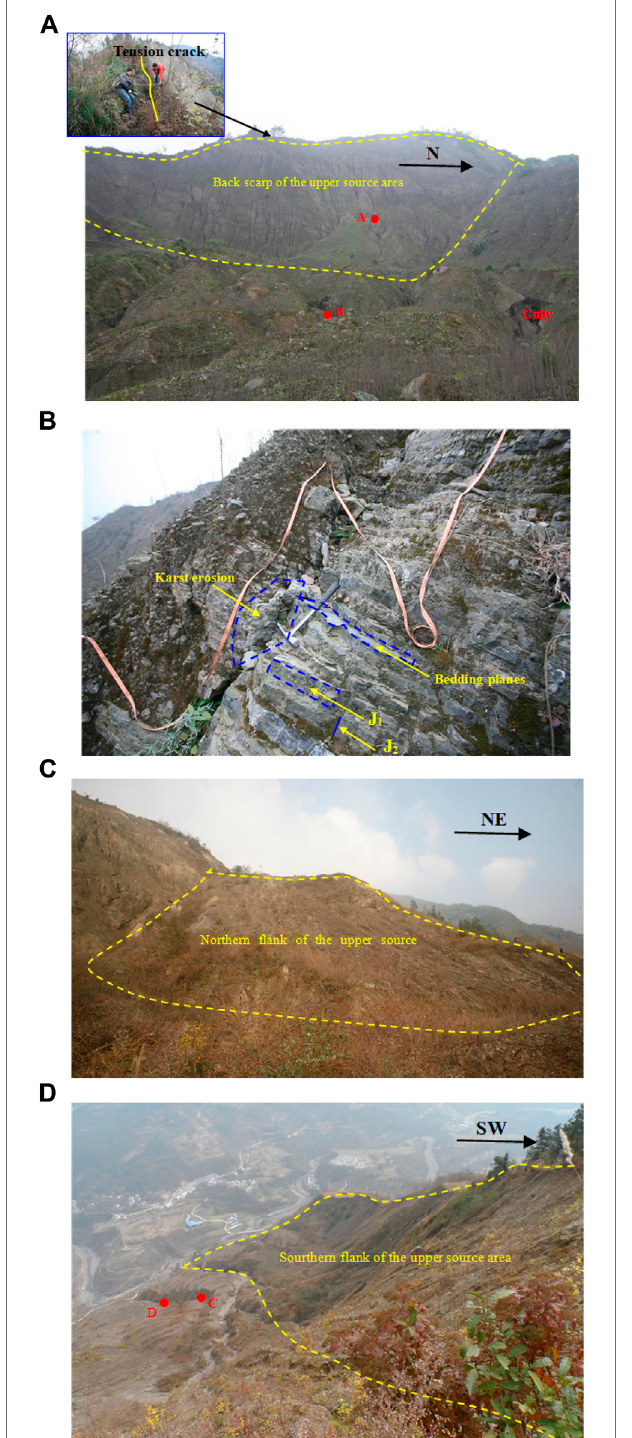
FIGURE 5 | Strata in the upper source area. (A) Sliding surface on the location spot B shown in Figure 4A . (B) Sliding surface on the location spot C shownin Figure4D . (C) SlidingsurfaceonthelocationspotDshownin Figure4D . (D) Carbonaceous and siliceous slate of Cambrian Qiujiahe Formation. (E) Sandstone intercalated with limestone of Cambrian Youfang Formation.